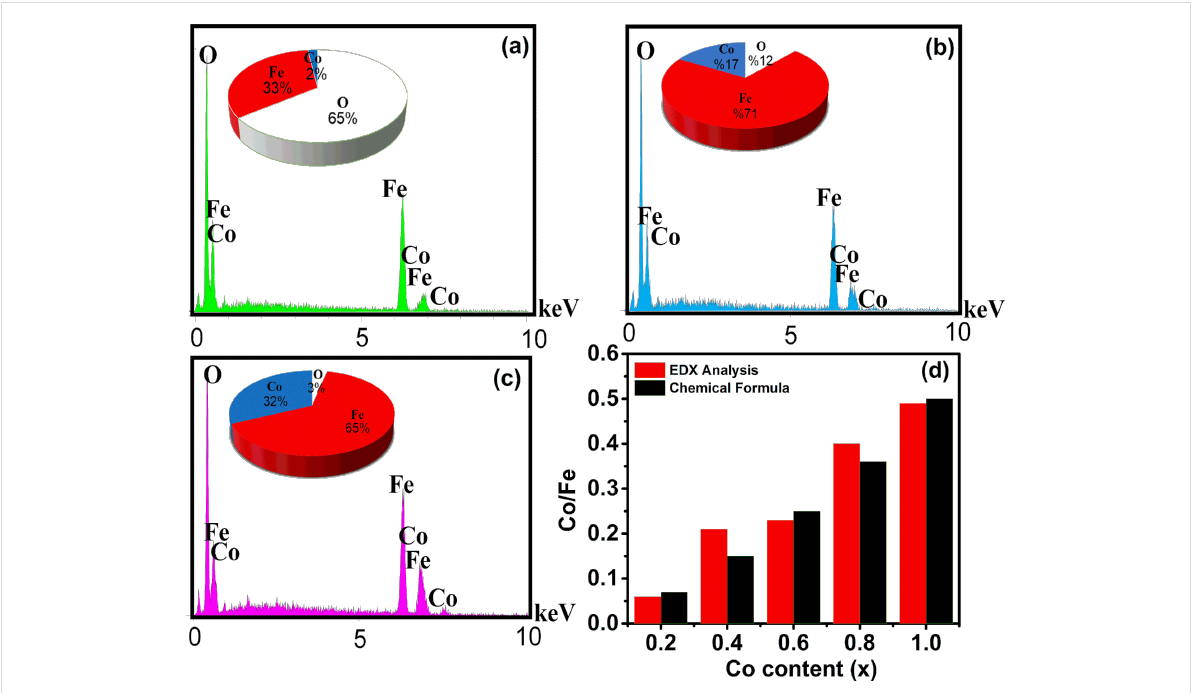
Figure 4: EDX spectra of Co x Fe 3 − x O 4 nanoparticles: (a) x = 0.2; (b) x = 0.6; and (c) x = 1.0. (d) Comparison of the Co/Fe atomic ratio obtained from EDX analysis and the theoretical stoichiometry of all samples.